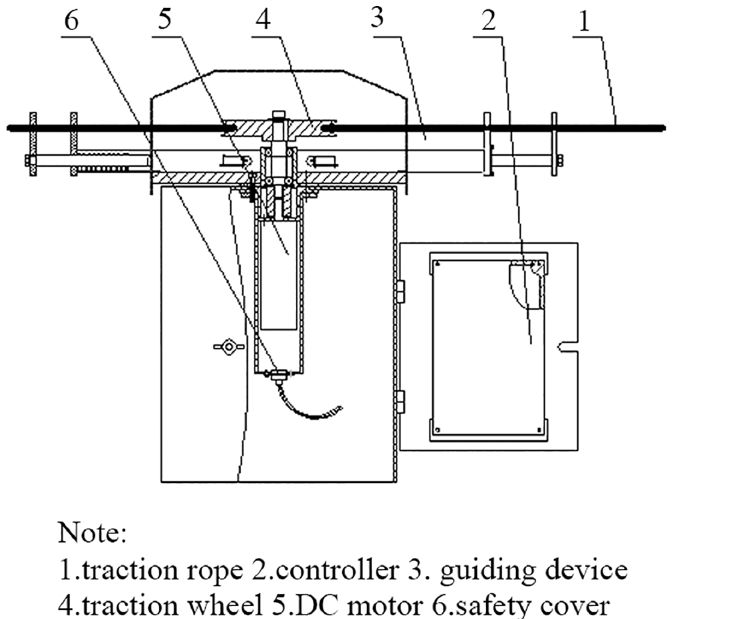
Fig 3. Structure of the water walking device of the